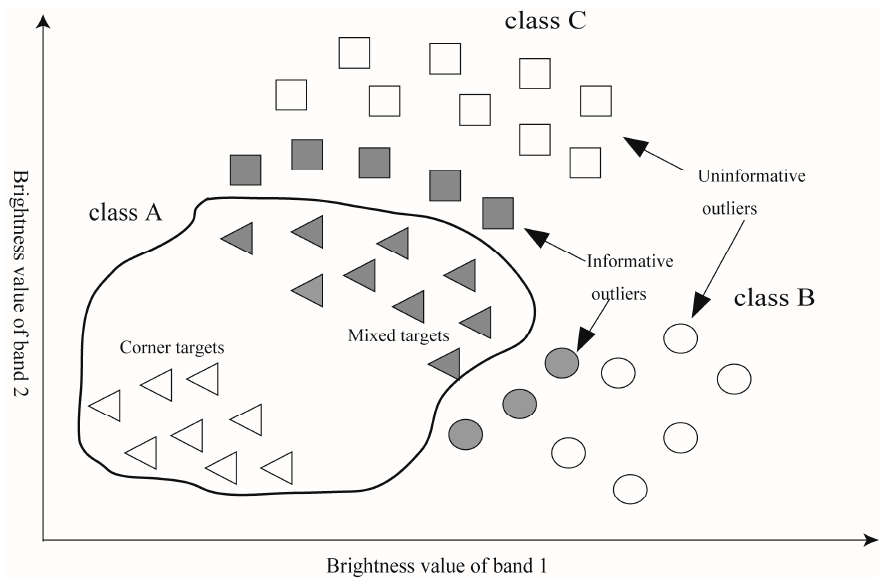
Figure 2. Definition of informative outliers from feature space. Circles and squares indicate cases of class of no interest (class B and class C) respectively, and triangles indicate cases of class of interest (class A). The solid line indicates the hypersphere fitted by target pixels. Solid circles and squares are located around the hypersphere, denoted as informative outliers.